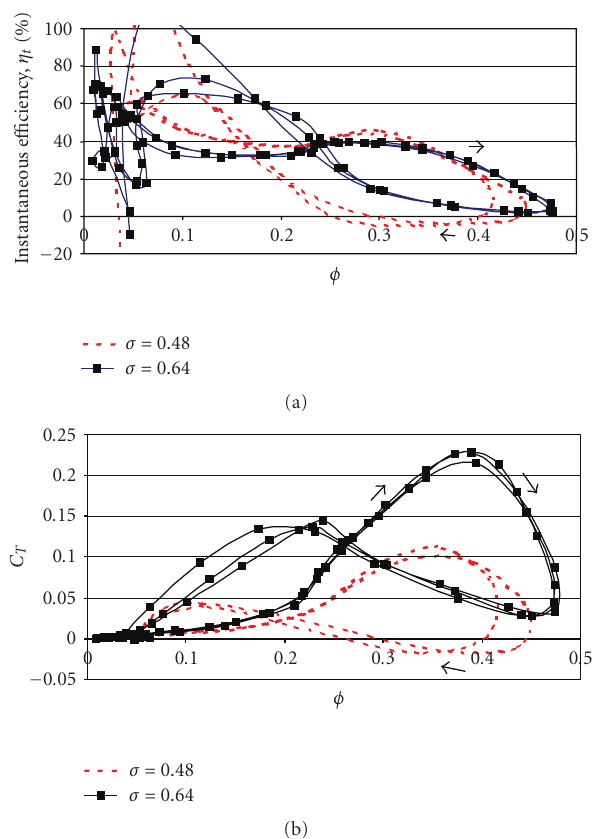
Figure 12: Variation of instantaneous e ffi ciency and torque coe ffi - cient of CA9 with σ = 0.48 and σ = 0.64 at value 1 /κω ∗ = 0 . 44: (a) e ffi ciency, (b) torque coe ffi cient.